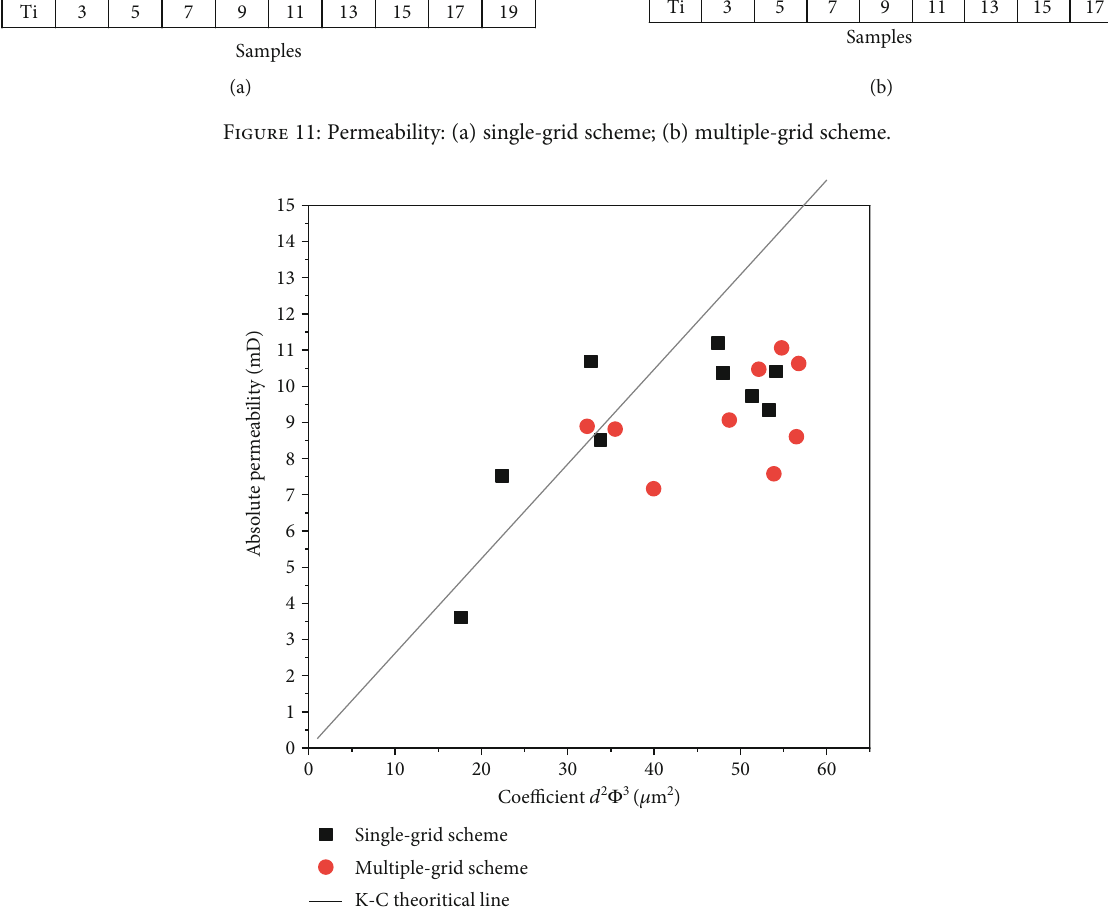
Figure 12: Porosity-permeability fi tting with K-C theoretical